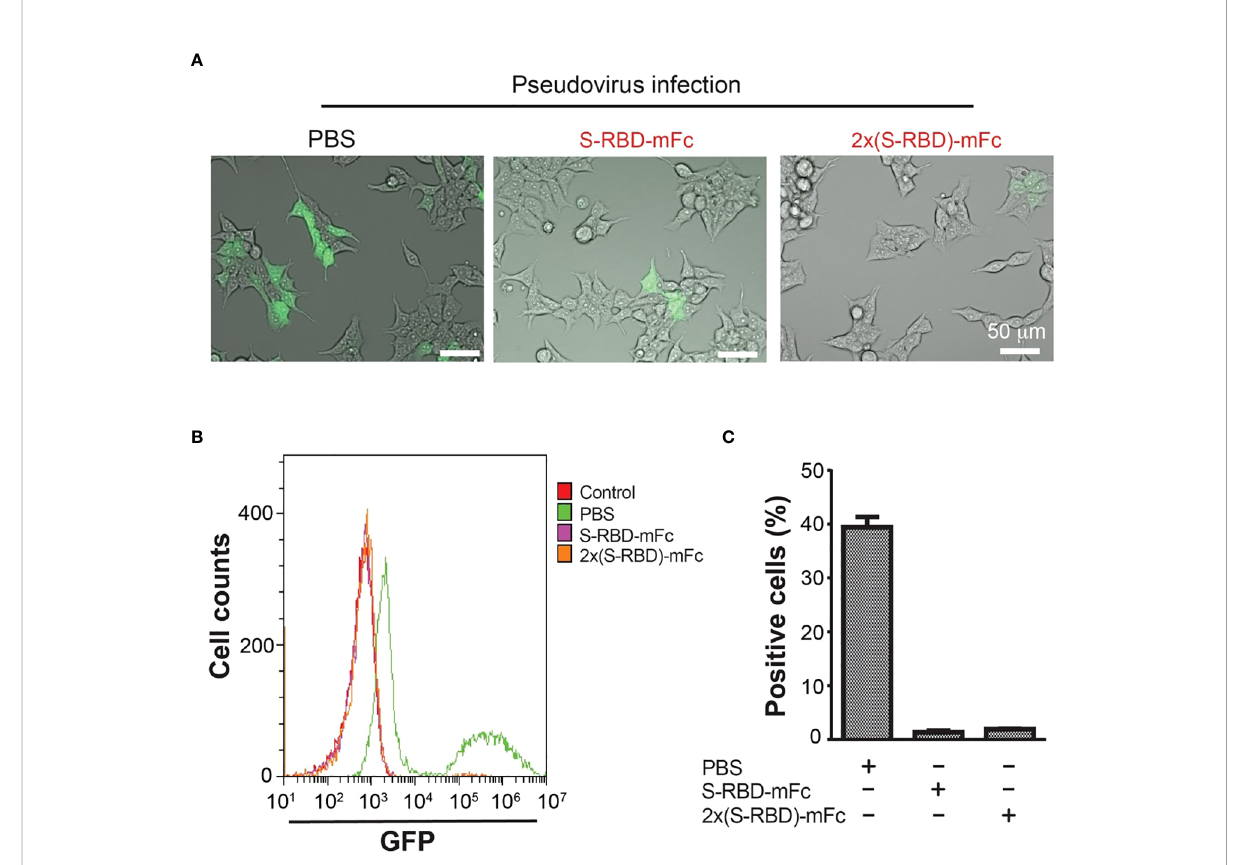
FIGURE 4 HEK293T-hACE2 cells infection by the SARS-CoV-2 S protein Pseudo virus was blocked by the S RBD -mFc and 2xS RBD -mFc fusion proteins. (A) Microscope images showing GFP expression in the HEK293T-hACE2 cells at 48h after incubation with SARS-CoV-2 Spike Pseudo virus premixed with PBS, S RBD -mFc and 2xS RBD -mFc. Scale bars, 50 µm. (B) Flow cytometry plots show cells of GFP expression. HEK293T-hACE2 cells without virus infection were analyzed as a negative control. Other cell groups were treated similar as described in (A) . (C) Mean values of cell percentages with high levels of GFP expression are shown (n =